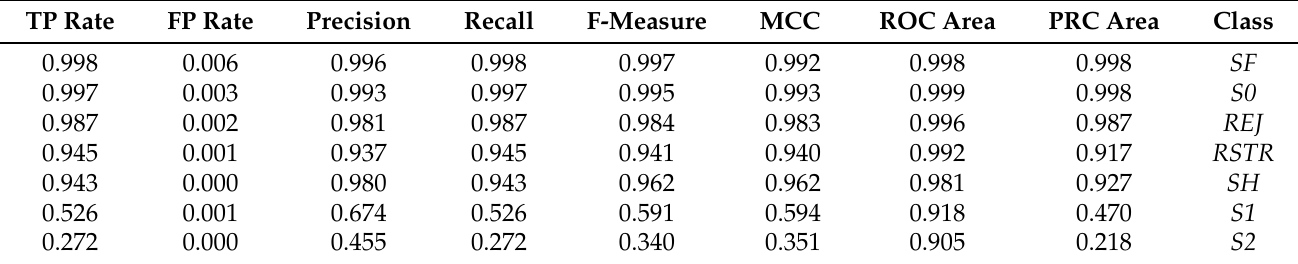
Table 4. Detailed accuracy by class with a